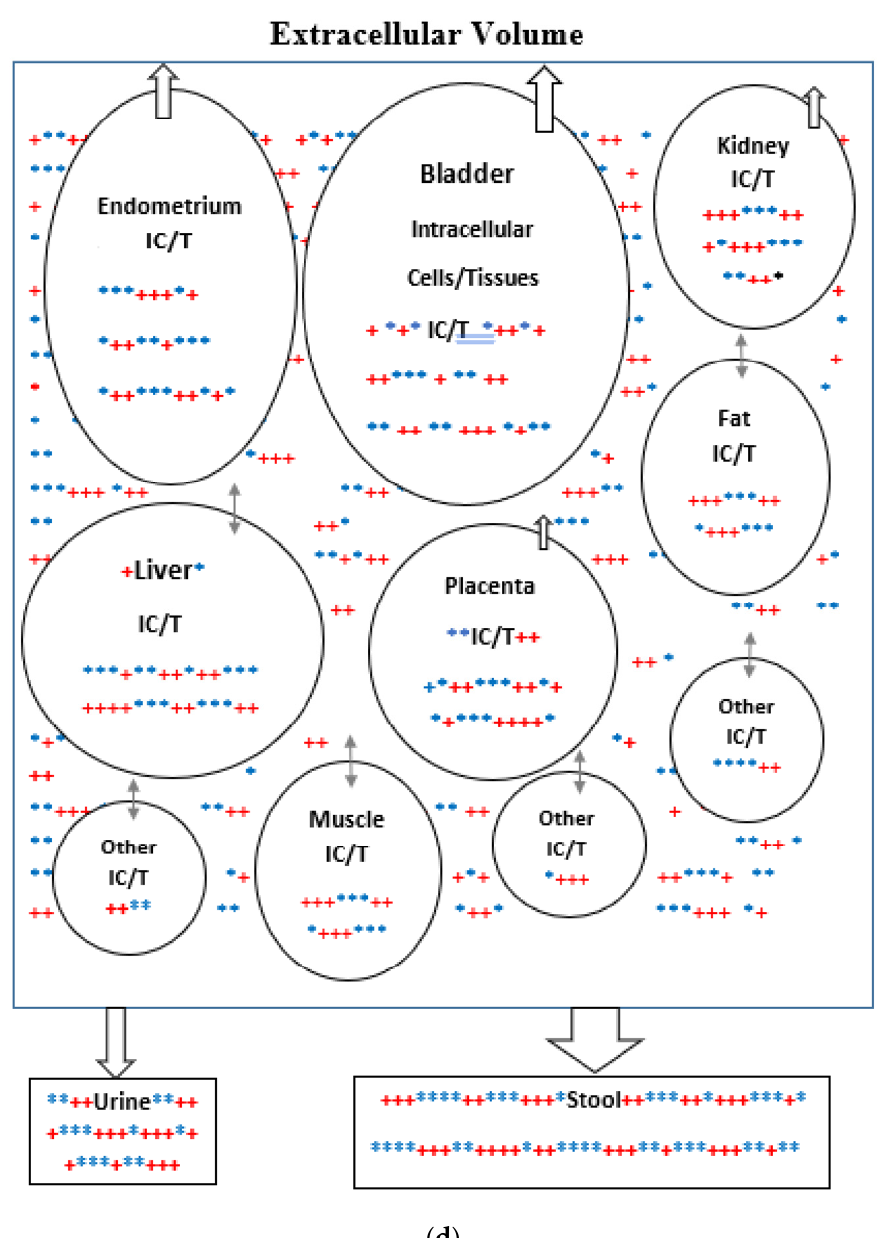
Figure 2. ( a ) Intracellular Vitamin D Pathways Describing the Conversion of 25(OH)D 3 , m 0 , to Its Initial and End Metabolites, m n . The C in front of the enzymes represents the carbon atom location which is acted upon by the pathway enzyme. The m n terms describe the initial, some of the intermediate, and the end metabolites of m 0 . The end metabolites (m 6 to m 10 ) pass from the intracellular to the extracellular compartments and are excreted in urine (approx. 25%) and in stool (approx. 75%). ( b ) Depicted in this Flow Diagram is the Intracellular Metabolism of 25(OH)D 3 , m 0 , to Its Initial Metabolites (m 1 , m 2 , and m 3 ), and to its End Metabolites in red (m 6 and m 7 ) that are diverted away from active vitamin synthesis. Also depicted is the Intracellular Metabolism of 1,25(OH) 2 , m 1 and its End Metabolites in red (m 8 , m 9 , and m 10 ). In this flow diagram, the m n terms represents the initial and end metabolites of m 0 ( i.e., m 1 through m 10 ). The large bold * symbols represent the enzymes for the synthesis of the initial metabolites of m 0 (25(OH)D 3 ). The small groups of three * symbols represent the enzymes which regulate the amount of end metabolites of active vitamin D hormone, m 1 , and the enzymes which regulate the amount of end metabolites of m 0 diverted away from m 1 synthesis in response to a changing need by the body for active vitamin D. ( c ) Model of the Body’s Synthesis, Transport, and Excretion of m 0 [25(OH)D 3 ], m 1 [1,25(OH) 2 D 3 ] and their End Metabolites, m 6 to m 10 (nmols/24 h). ( d ) Simple Model of the Body’s Composition of Non m 1 End Metabolites from [25(OH)D 3 ], m 6 and m 7 (*), and End Metabolites from m 1 [1,25(OH) 2 D 3 ], m 8 to m 10 (+), at any point in time, t, in moles. The open space in the box is the extracellular space and the circles/ovals represent the intracellular space/tissues (IC/T). The size of the arrows indicates the amount of